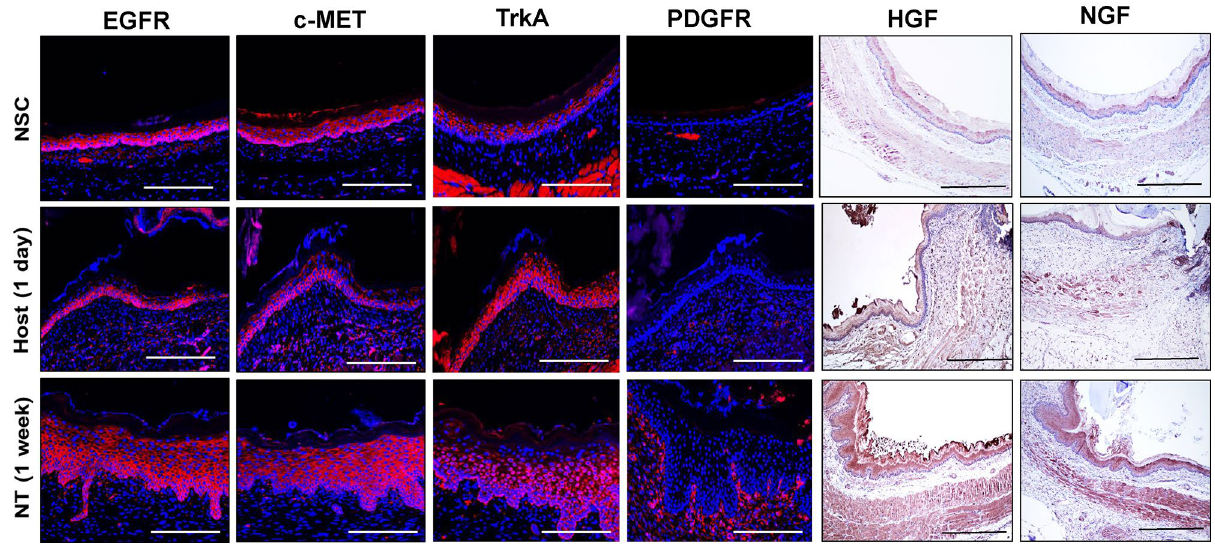
Figure 4. Expression of selective receptor tyrosine kinases and their associated ligands in control and neotissues. Representative photomicrographs of mucosa in nonsurgical controls (NSC), host-graft interface at 1 day post-op, and in neotissues (NT) at 7 days following graft implantation. For columns 1–4, respective marker expression is displayed in red with DAPI nuclear counterstain in blue. For columns 5 and 6, respective marker expression is denoted in brown (HRP labeling) with hematoxylin nuclear counterstain in blue. Scale bars for all panels = 200